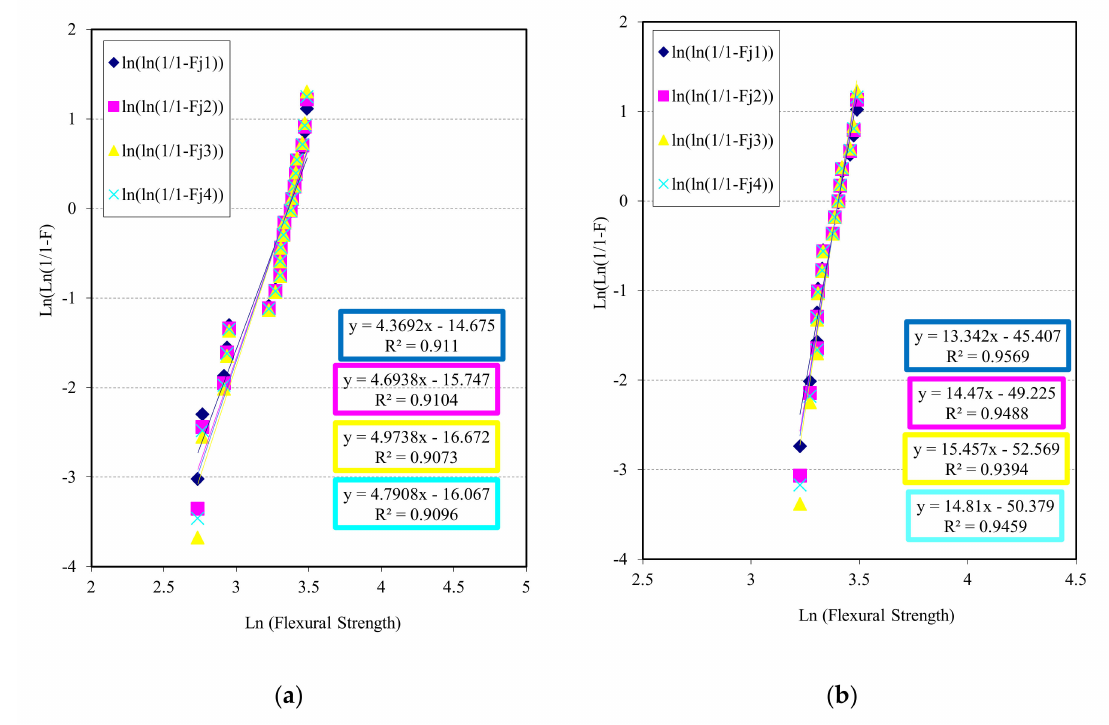
Figure 10. Weibull plots for chosen failure estimators using flexural strength as a key property for tests of conditions G1: ( a ) for all samples and ( b ) eliminated samples with premature